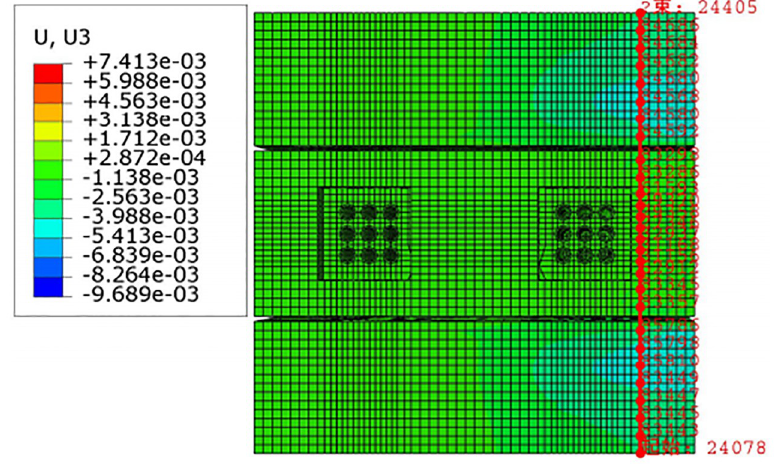
Fig 9. Node selection position.